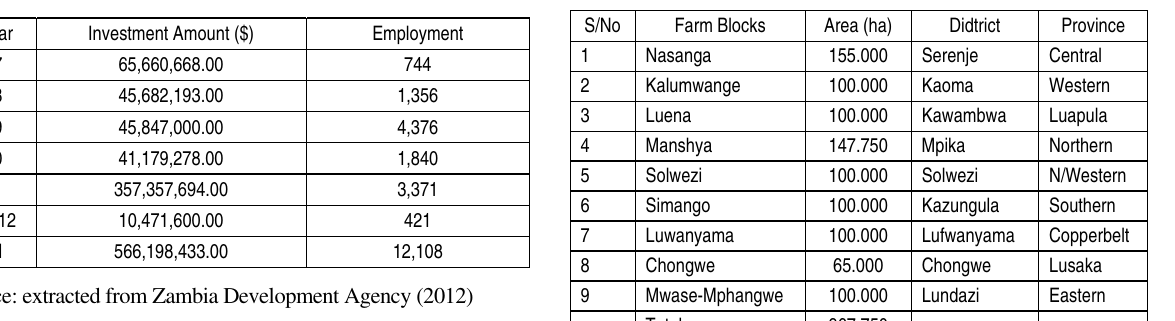
Table 3. Agricultural investment pledges by year and sector 2007-Jan 2012 Table 4. Proposed farm blocks as at